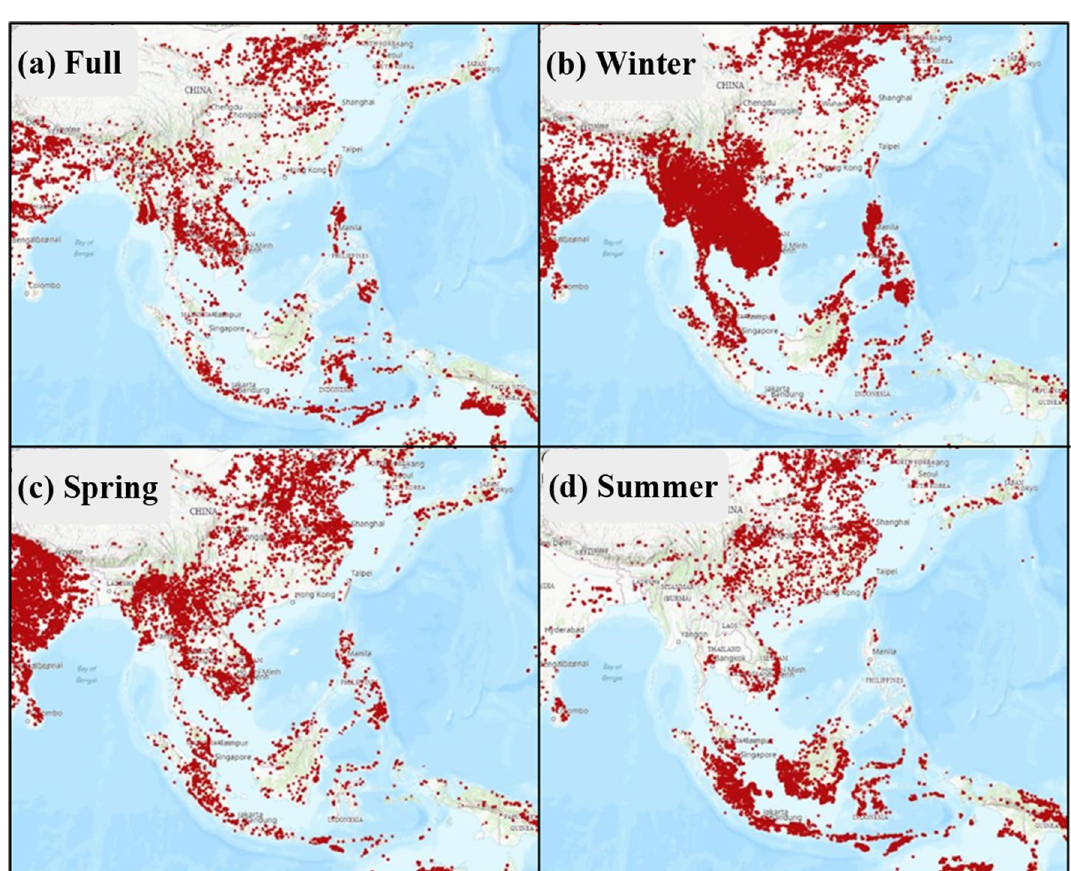
Figure 6. Fire maps in the East and South Asia measured by the NASA MODIS